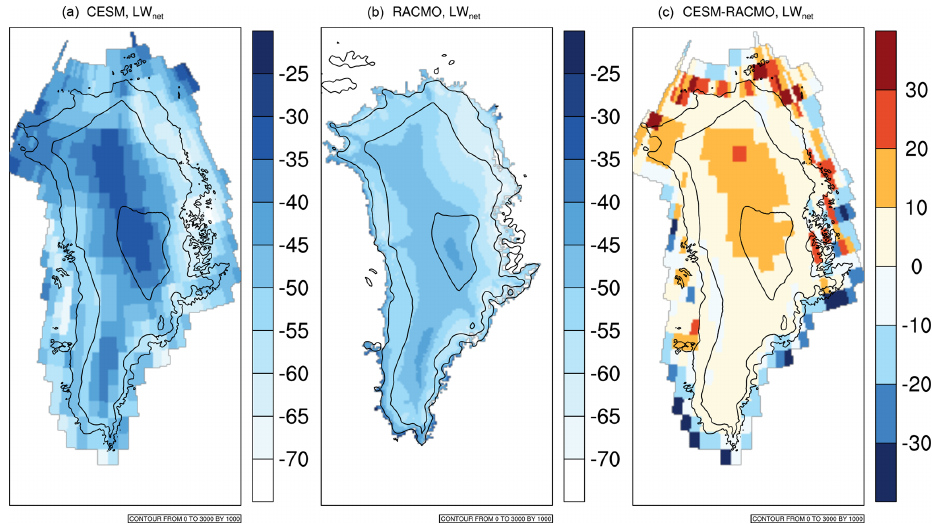
Figure 5. Summer net longwave radiation (Wm − 2 ) for CESM (a) , RACMO2.3 (b) , and the difference (c) . The black solid lines denote elevation at 0, 1000, 2000, and 3000km levels in each grid. The CESM elevation (b, c) uses the 5km downscaled values.